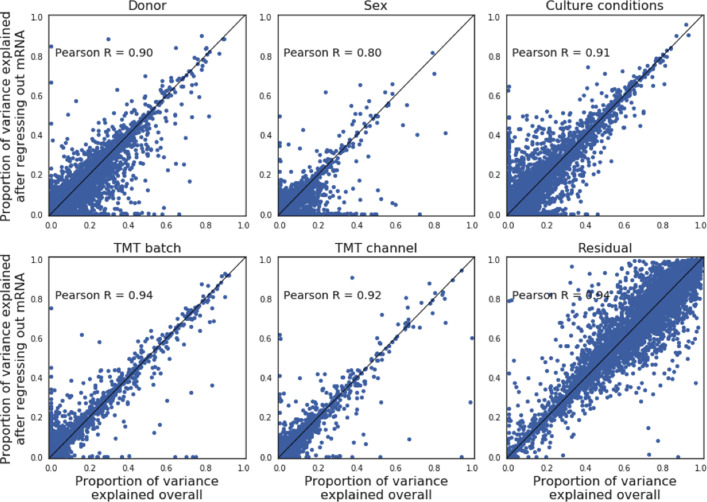
Comparisons of variance component estimates before and after regressing out mRNA effects.Briefly, for each protein-RNA pair, the effect of RNA abundance on protein abundance was accounted for using a linear model, regressing out its effect on the protein abundance. The analogous variance component model as considered in Figure 1b is then fitted on this adjusted protein abundance (Materials and methods).